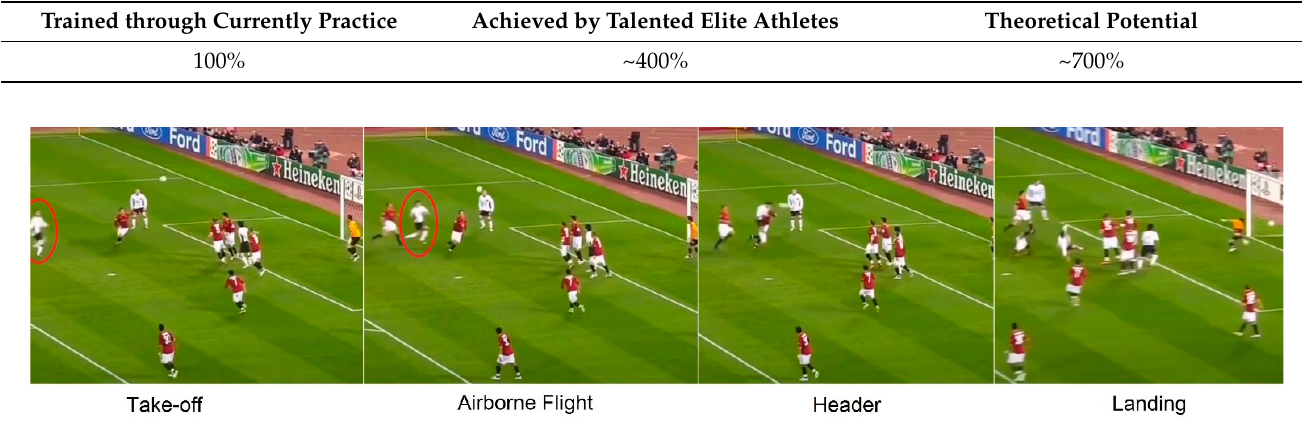
Figure 4. The long-jump header (the player is identified in red circle on the two left frames). Currently, there is no study available for revealing the 3D dimension of this SST (the figure was generated from the video of UEFA TV video, published in 2021 [60]).